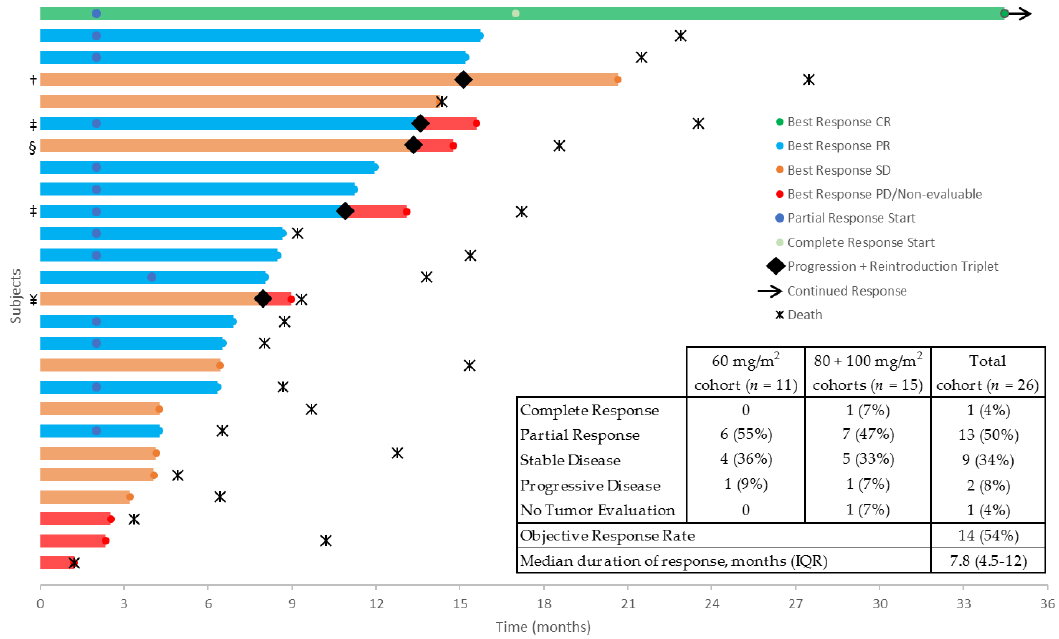
Figure 3. Swimmer plot of radiological response and duration of response. CR: complete response;